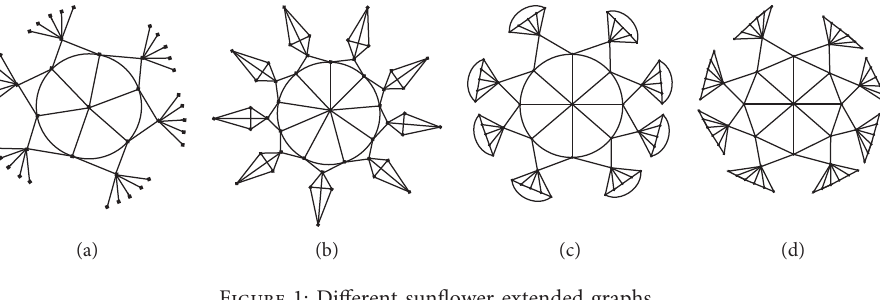
Figure 1: Different sunflower extended graphs.